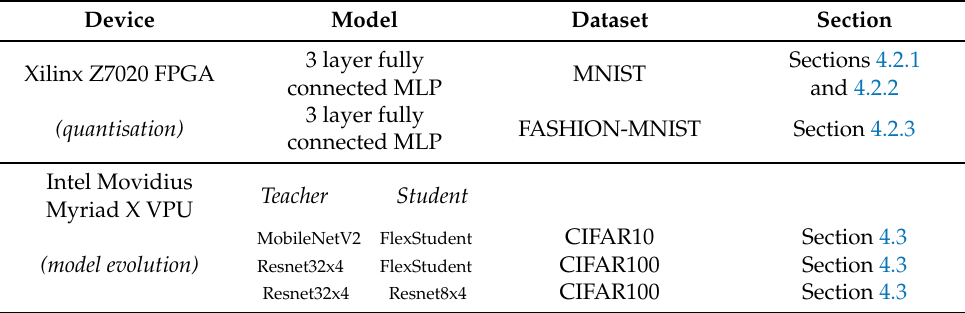
Table 2. Quantisation and model evolution